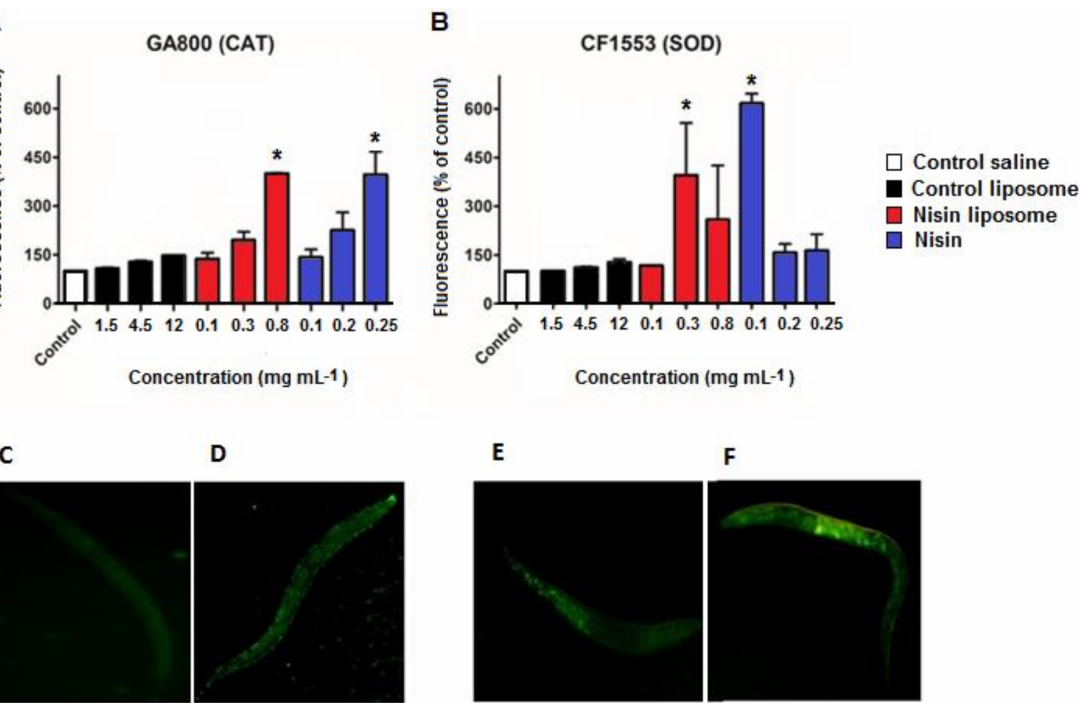
Figure 3. Quantification of fluorescence of ( A ) GA800 (CAT) and ( B ) CF1553 (SOD) strains after exposure to liposomes with nisin (red) or free nisin (blue). Controls were performed by incubation in saline solution (0.085 mol L − 1 NaCl) or in the presence of empty liposomes. Values for control liposomes are expressed as PC concentration, corresponding to the equivalent PC amount of lipo- somes containing 0.1, 0.3, and 0.8 mg mL − 1 nisin, respectively. The photographs are representative of the control animals ( C , E ) for CAT and SOD, respectively, and of the samples with higher fluo- rescence: CAT for nisin at 0.25 mg mL − 1 ( D ) and SOD for nisin at 0.1 mg mL − 1 ( F ). Values are the means ± standard deviations of three independent experiments. * denotes significant differences with control saline ( p < 0.05), which was set as